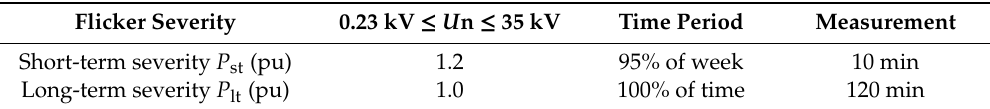
Table 2. Parameters of flicker severity